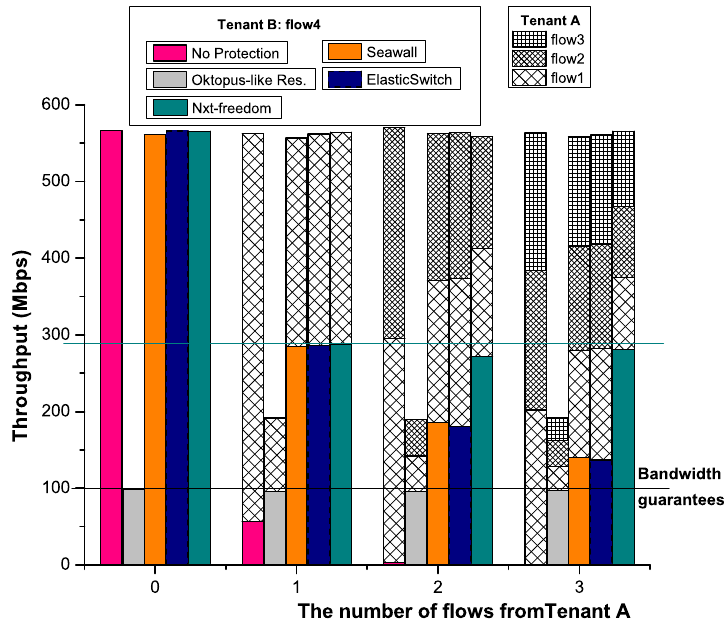
Figure 10. Comparison with state of the